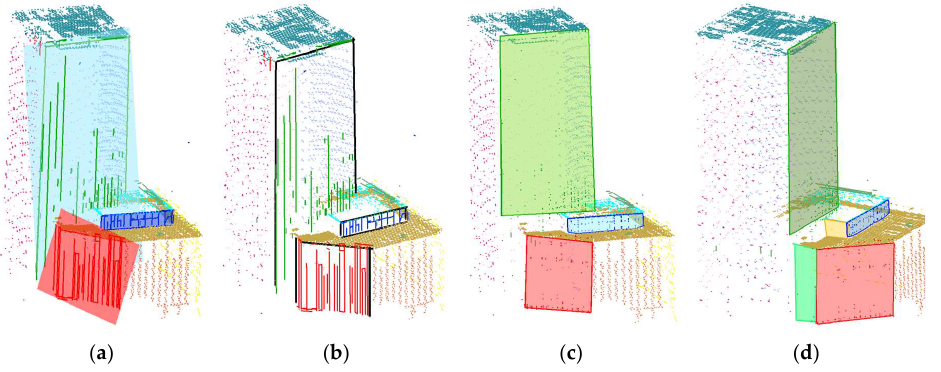
Figure 11. The pipeline to construct planes by plane deduction. ( a ) The LaP group segmented by plane detection from lines. ( b ) Validated LaL unit on the LaP group. ( c ) The structural contour of the validated LaP. ( d ) Another two new planes validated by the next iteration.